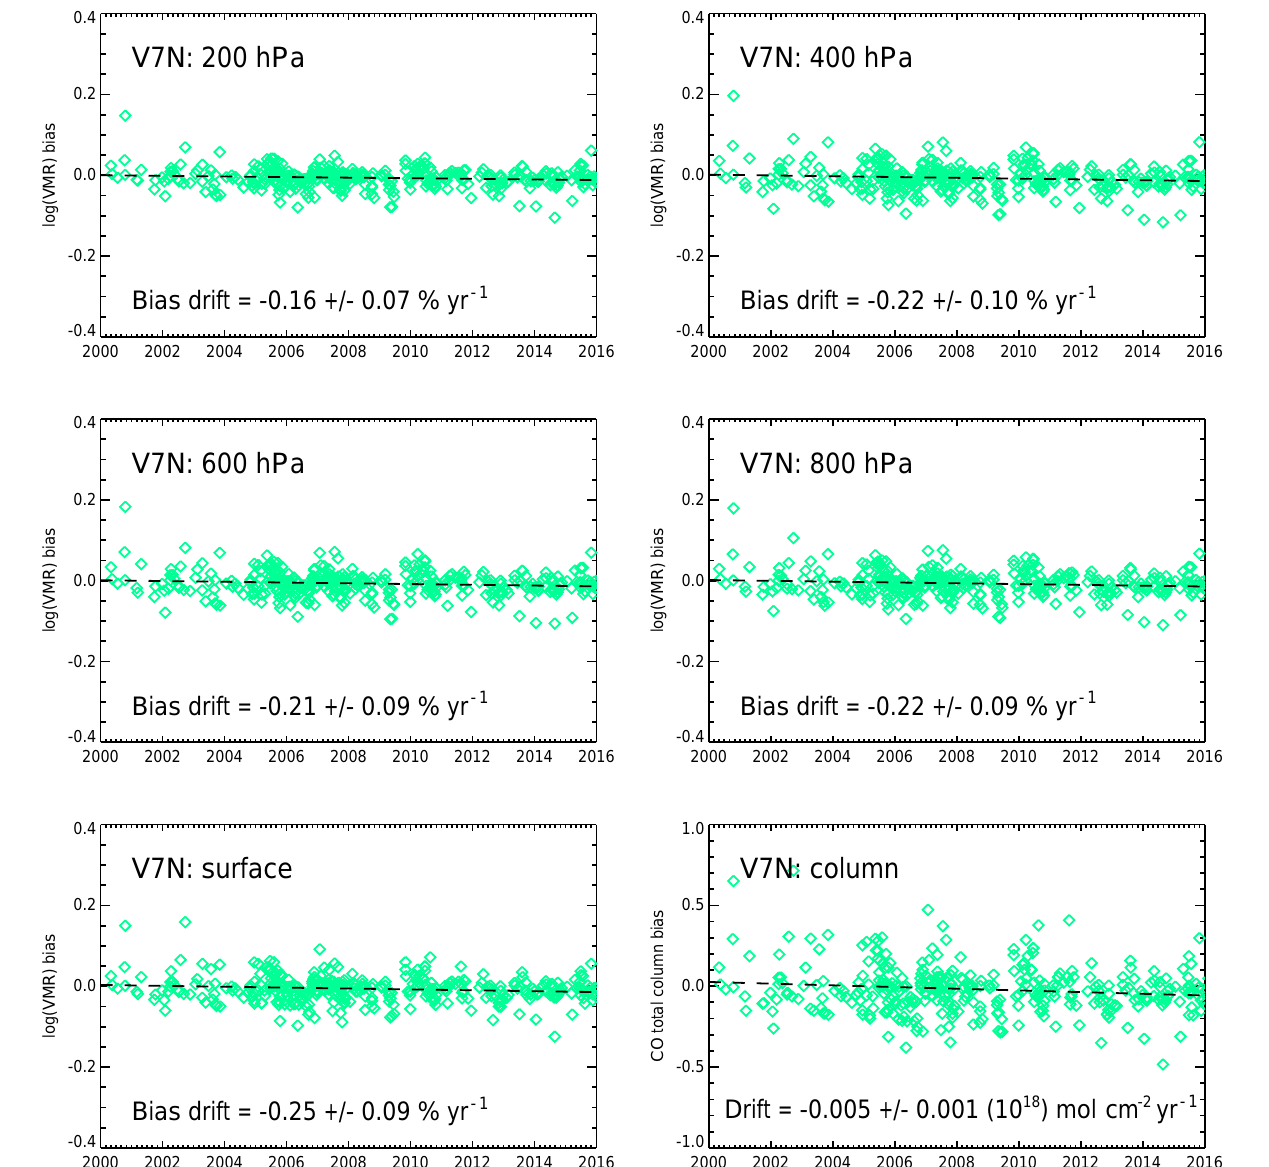
Figure 14. Retrieval bias drift for V7 NIR-only products based on the NOAA flask measurements. See caption to Fig. 11.